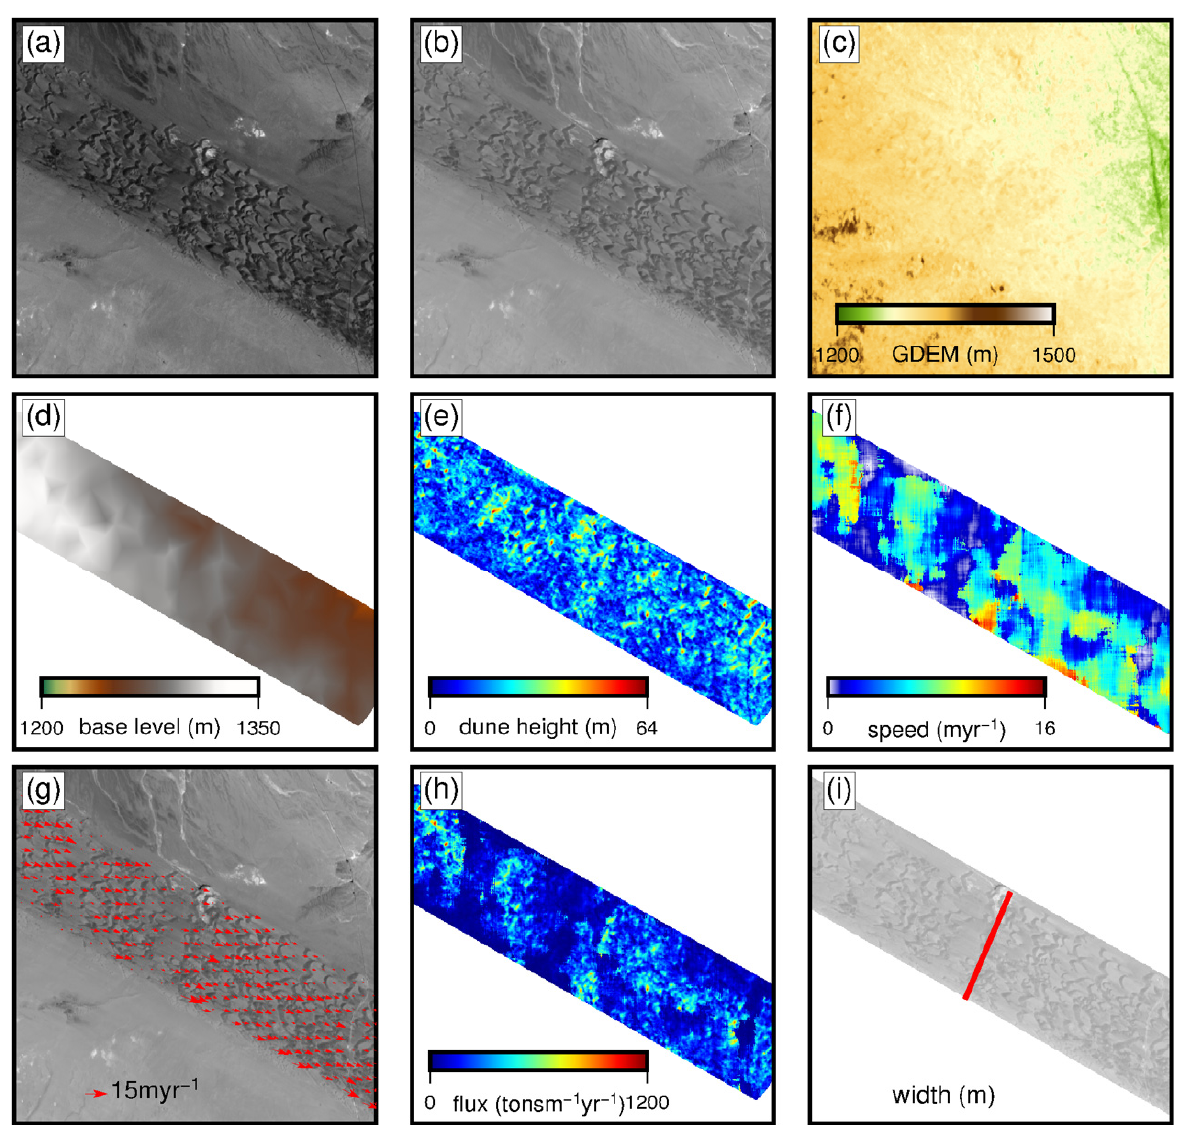
Figure 5. Estimation of the sand flux using remote sensing and DEM: ( a , b ) are the original Landsat 5 and 8 images, ( c ) is the raw ASTER GDEM, ( d ) is the “base level” estimated from the raw DEM, ( e ) shows the dune’s height, ( f , g ) show the displacement map and its vector field, ( h ) is the sand flux of each pixel, and ( i ) shows the width of the sand flux, which is perpendicular to the wind direction.